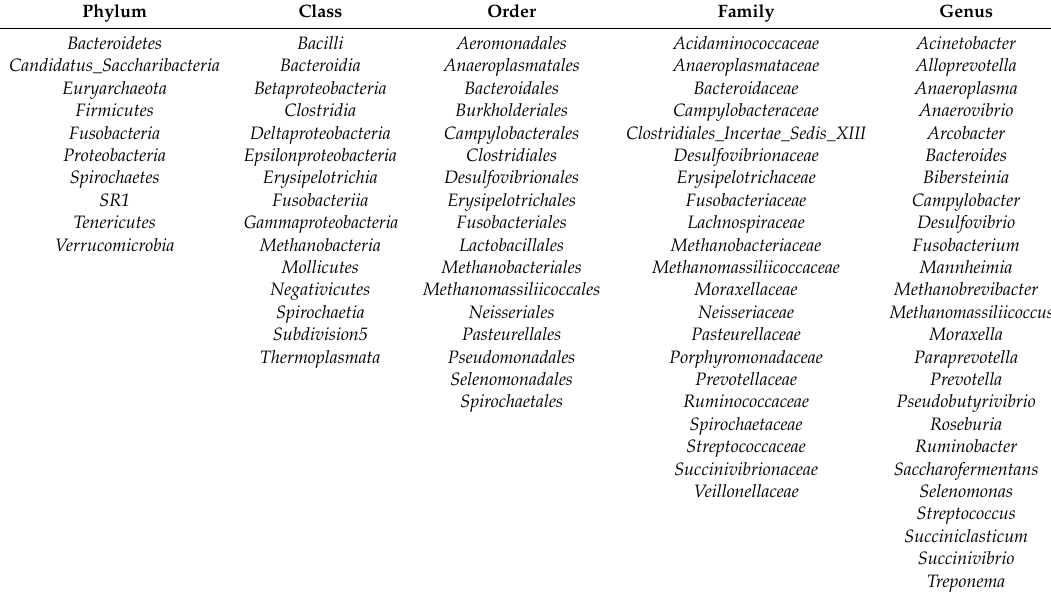
Table 4. Taxonomic groups shared by all